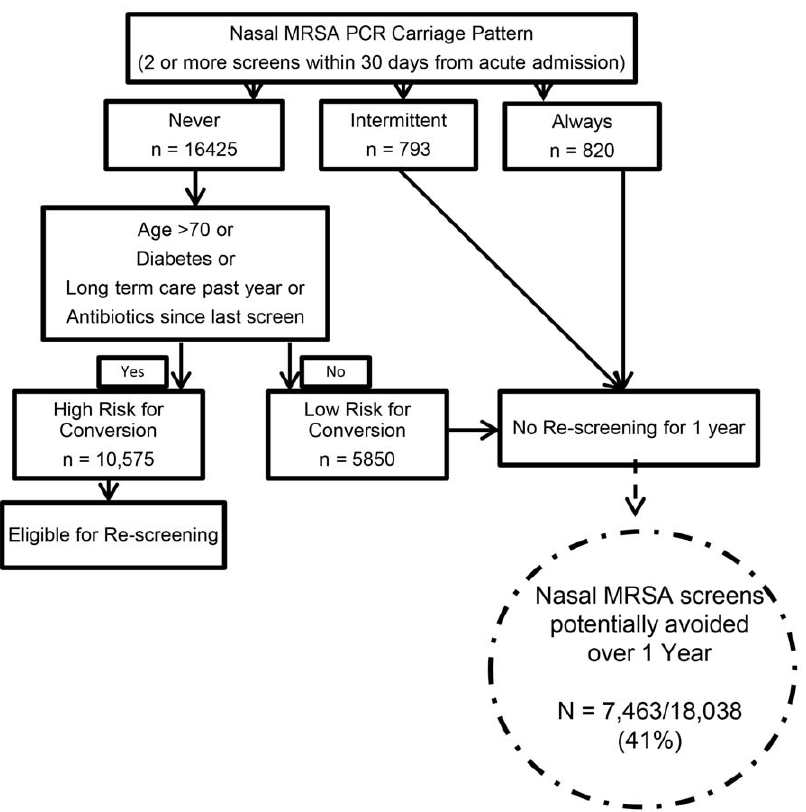
Figure 2. Proposed Algorithm for Reducing Screening. Number of nasal MRSA screens avoided by application of the initial carriage pattern and clinical criteria identifying patients at low risk for conversion.